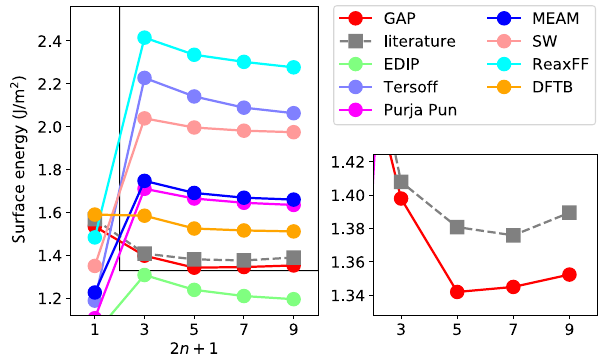
model.FIG. 13. Formation energy of the dimer-adatom-stacking-fault (DAS) reconstruction of the (111) surface for various surface unit cell sizes 2 n þ 1 ¼ ð 3 ; 5 ; 7 ; 9 Þ computed with different models. The value shown at 2 n þ 1 ¼ 1 corresponds not to a DAS reconstruction but rather to the unreconstructed surface. The box on the lower right is a magnified view that shows just the DFT and GAP